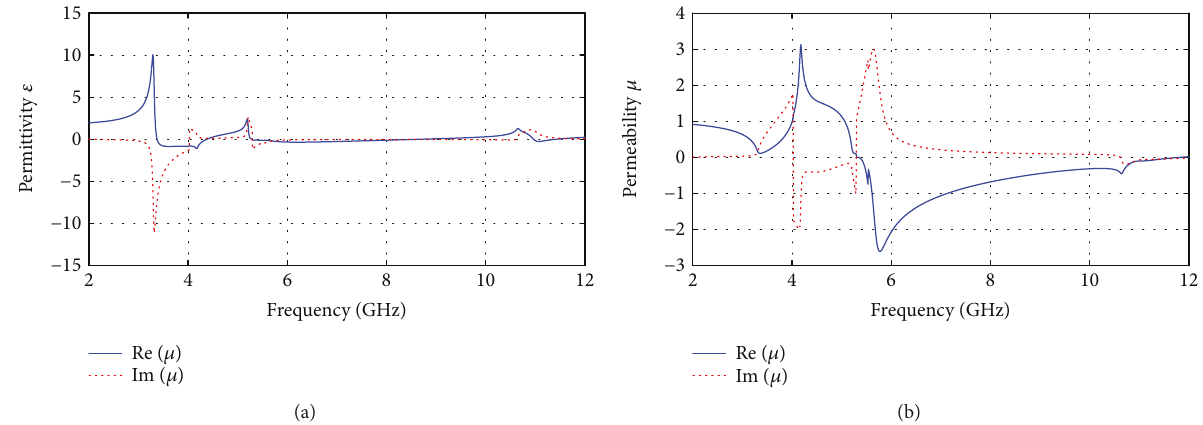
Figure 2: (a) The extracted e ff ective permittivity. (b) The extracted e ff ective permeability.